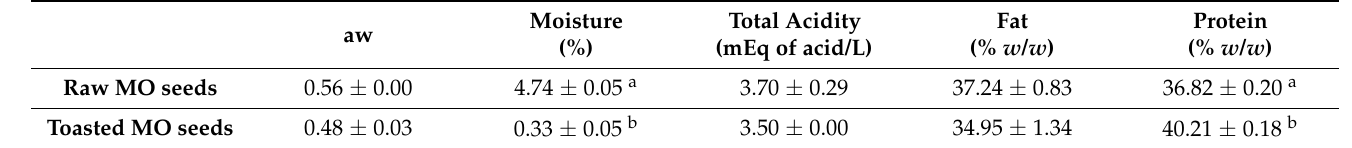
Table 2. Results of physico-chemical analysis of raw and toasted Moringa oleifera seeds. Values are represented as mean ± standard deviation ( n = 3). Different letters in samples, per parameter, indicate significant differences between them ( p <